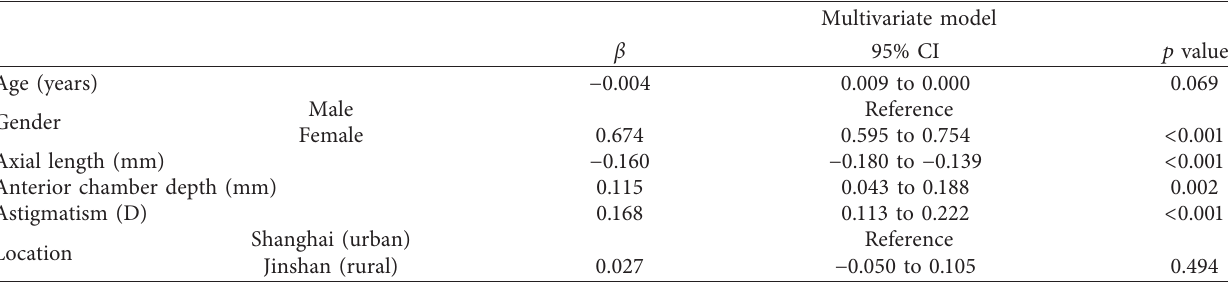
Table 6: Associations of K with systemic and ocular factors.